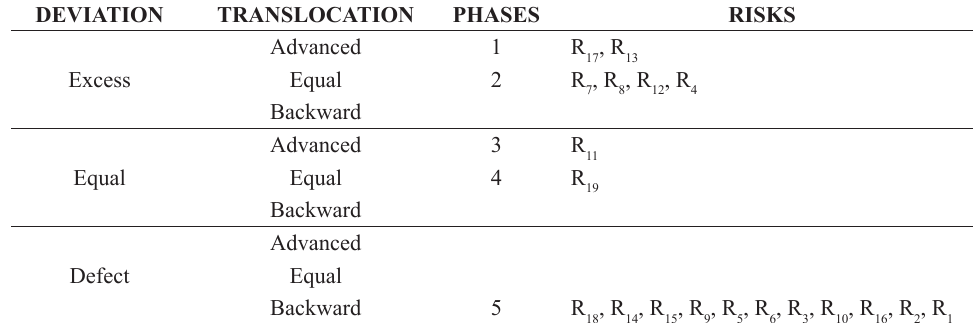
SIAS vs ACSOM Phases.